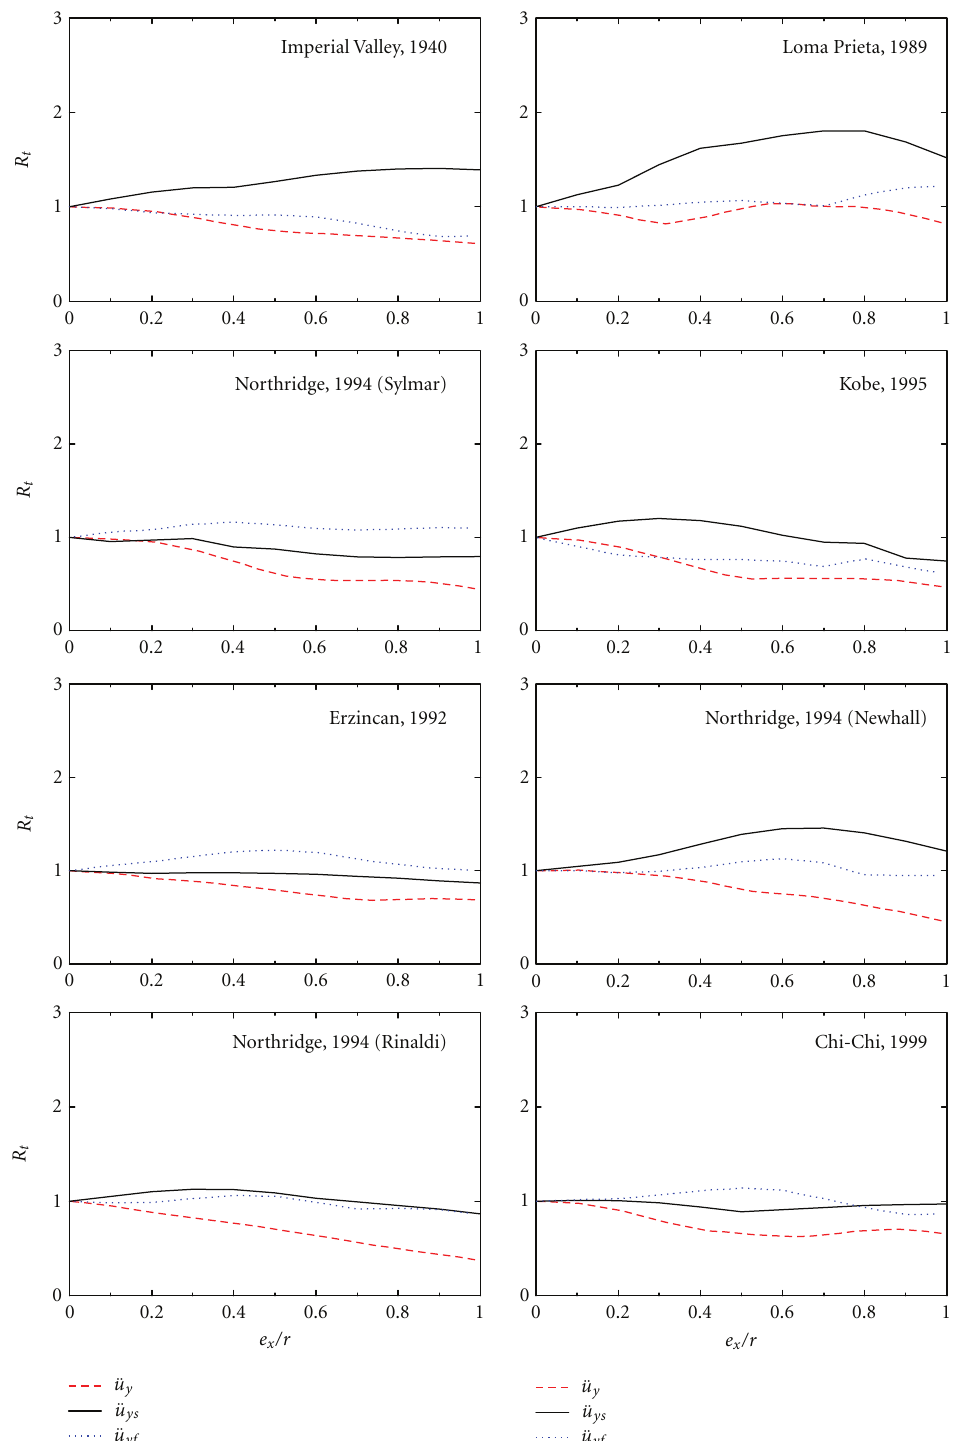
Figure 15: E ff ect of eccentricity on response ratio, R t for various peak accelerations ( T y = 1 s, Ω θ = 1). all considered values of e x / r implying that the semiactive and corresponding uncontrolled system and its value less than one indicates that the control system is e ff ective in MR dampers using clipped-optimal algorithm is e ff ective reducing the responses. It can be noticed from the figure that in reducing peak lateral-torsional responses. It is further the ratio, R e , for lateral, edge, and torsional displacements noticed that for strongly coupled system ( Ω θ = 1), the and accelerations comes out to be less than unity for values of ratio, R e , for torsional displacement, u θ ,